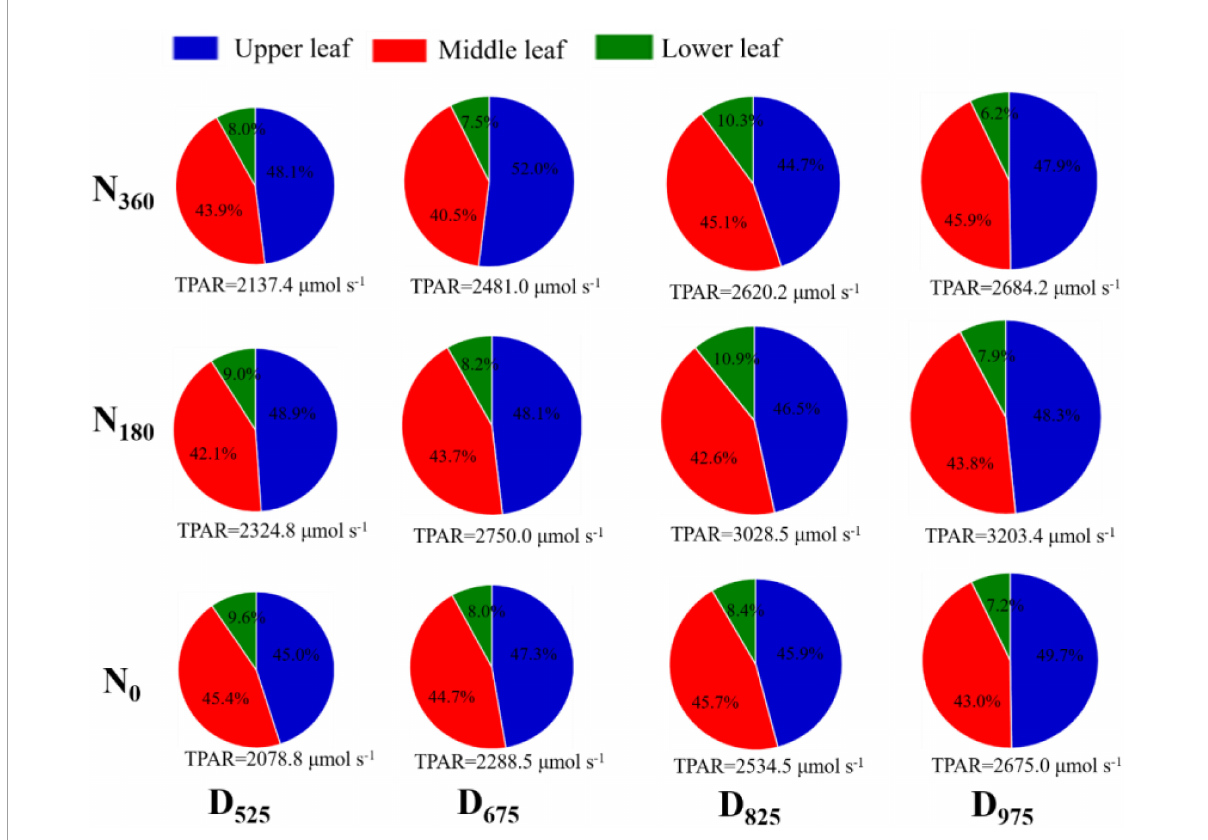
FIGURE5 Influence of N rate and plant density on the photosynthetically active radiation (PAR) at different leaf positions in 2019. The size of pie diagram represents the TPAR of different leaf layers; the percentage of each section represents the TPAR ratio for the upper, middle, and lower leaf layers.